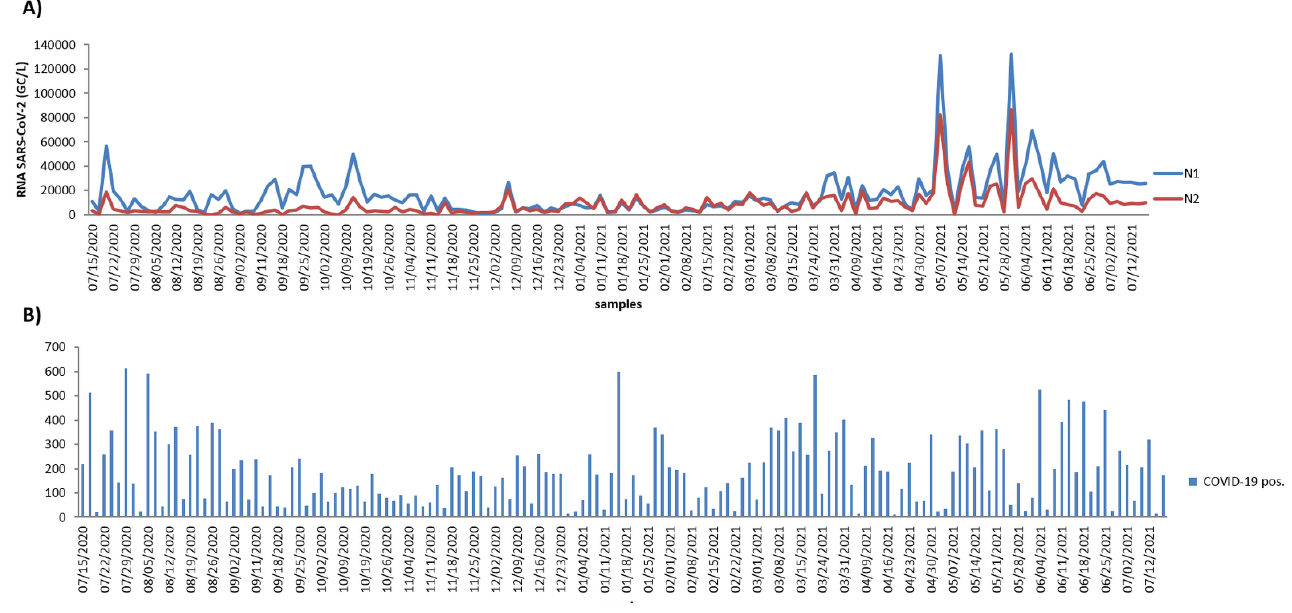
Figure 1. SARS-CoV-2 RNA quantification of the wastewater from São José do Rio Preto and SARS-CoV-2-positive cases in São José do Rio Preto. ( A ) SARS-CoV-2 RNA quantification in the wastewater samples in São José do Rio Preto during one year using the N1 target (blue line) and the N2 target (red line) and ( B ) SARS-CoV-2-positive cases in São José do Rio Preto diagnosed during one year.